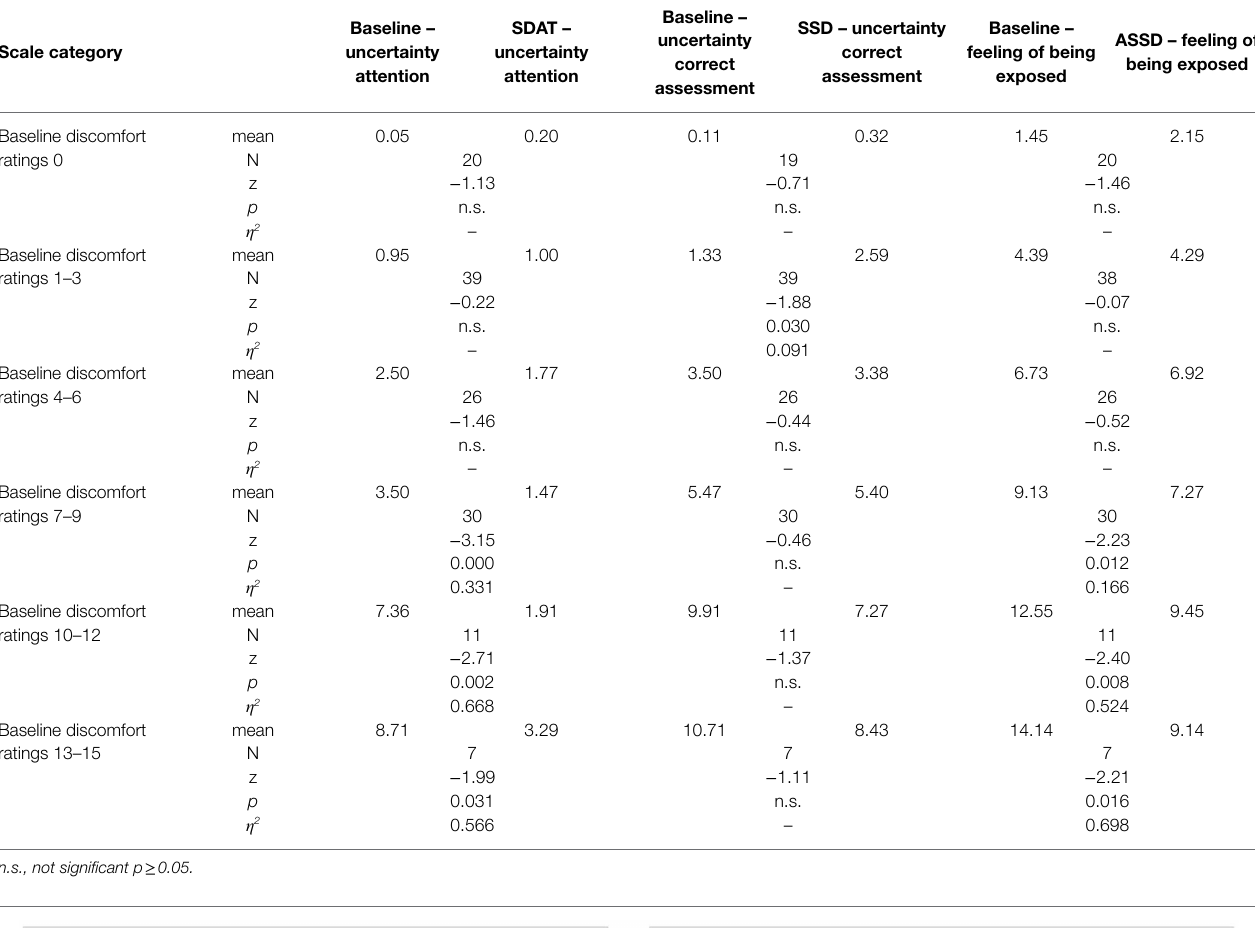
TABLE 5 | Exact Wilcoxon-Tests (one-sided) for differences in the specific effects of the assistances systems between assisted and non-assisted rides by scale category of the baseline discomfort